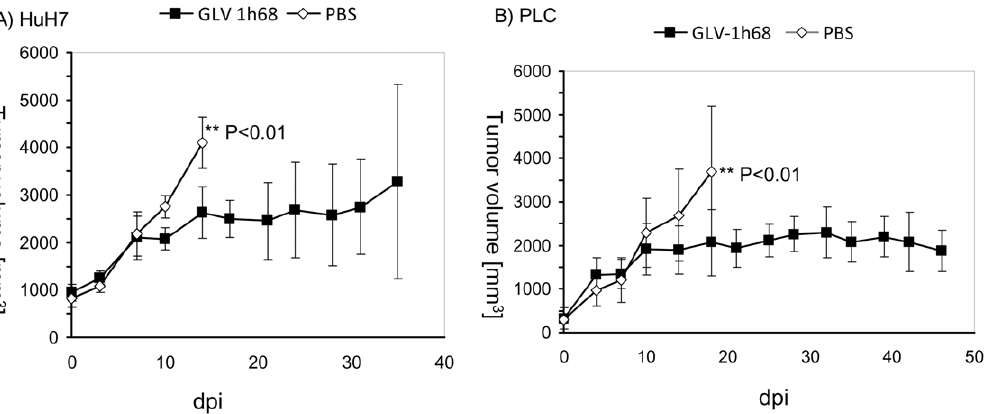
Figure 3. Growth of HuH7 and PLC tumors in GLV-1h68- and mock-treated mice. Groups of HuH7 (Fig. 5A) or PLC tumor-bearing nude mice (Fig. 5B) were either treated with a single dose of 5 6 10 6 pfu GLV-1h68 (n=5) or with PBS (mock control, n=5). Tumor size was measured twice a week. Two-way analysis of variance (2way ANOVA) with Bonferroni post-test was used for comparison of two corresponding data points between groups. P , 0.05 was considered statistically significant. ** P , 0.01. In addition, statistical power was calculated post-hoc using G*power 3.1.2 software (http://www.psycho.uni-duesseldorf.de/abteilungen/aap/gpower3/). The statistical power for alpha =0.05 was 75%, for alpha=0.01 42%.